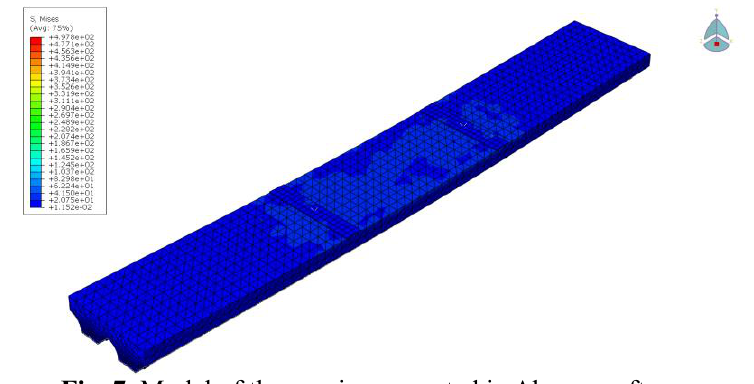
Fig. 7. Model of the specimen created in Abaqus software.